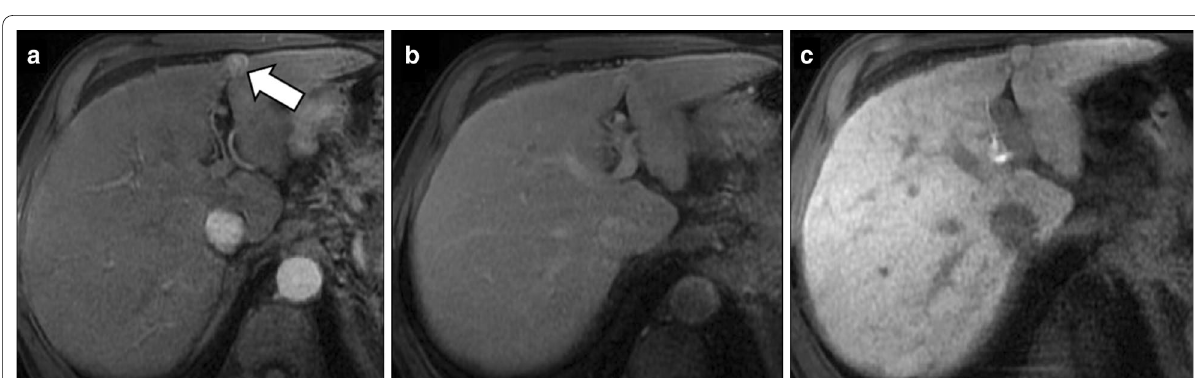
Fig. 12 A 65‑year‑old patient with HCV‑related cirrhosis and hepatocellular carcinoma. Gadobenate dimeglumine‑enhanced MRI shows an HCC with ( a ) arterial phase hyperenhancement (arrow) in the arterial phase, ( b ) non‑peripheral washout in the portal venous phase and ( c ) iso‑hyperintensity in the hepatobiliary phase surrounded by a non‑enhancing